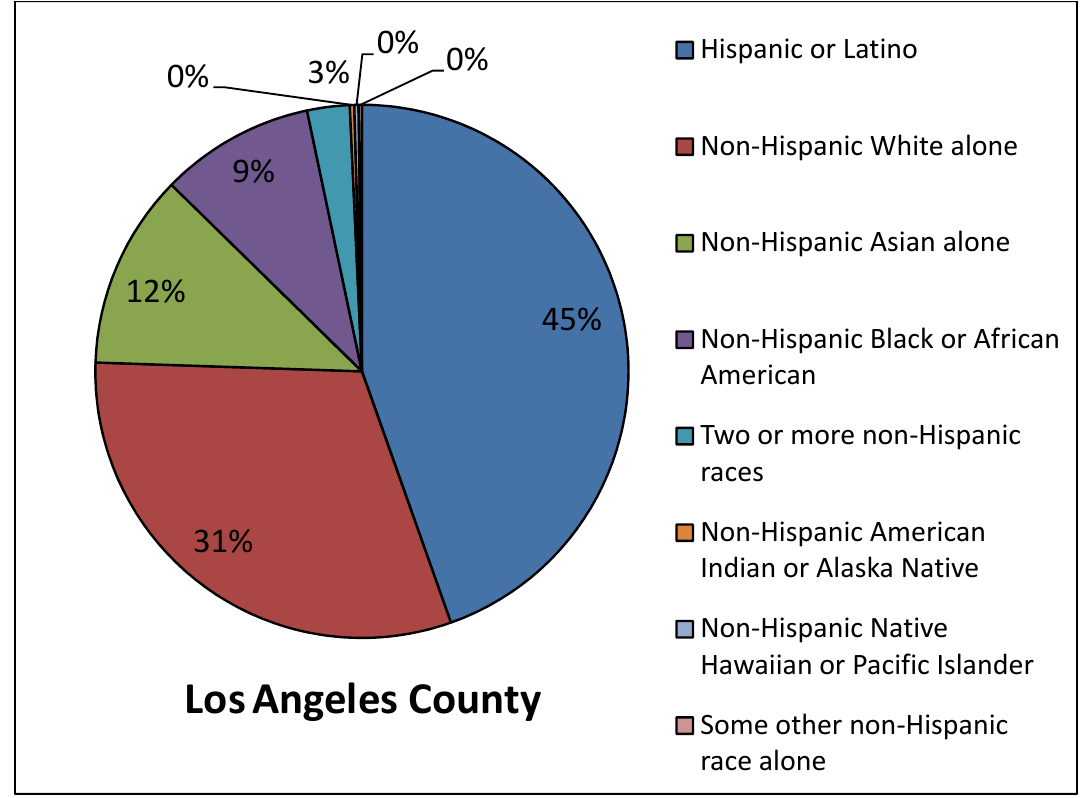
Figure 9. Demographics of the population in Los Angeles County at the time that Union Pacific announced it wanted to expand the UP ICTF rail yard, 2000 census